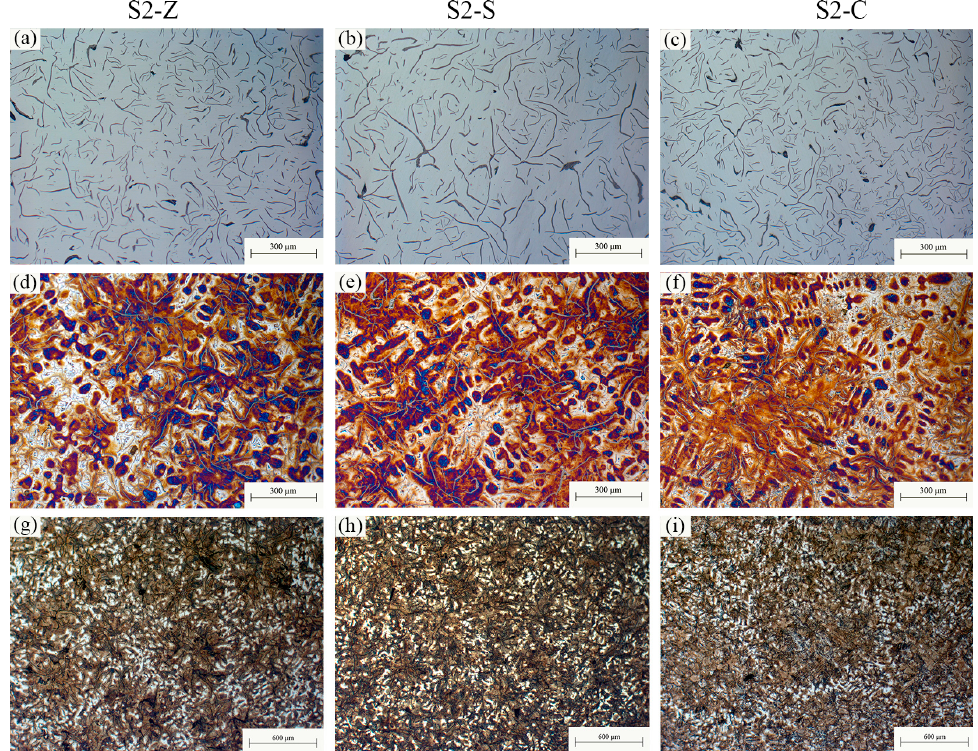
Figure 3. Metallographic images of S2 ‐ Z ( a , d , g ), S2 ‐ S ( b , e , h ) and S2 ‐ C ( c , f , i ), showing graphite ( a – c ), primary dendrite ( d – f ), and eutectic colonies ( g – i ).